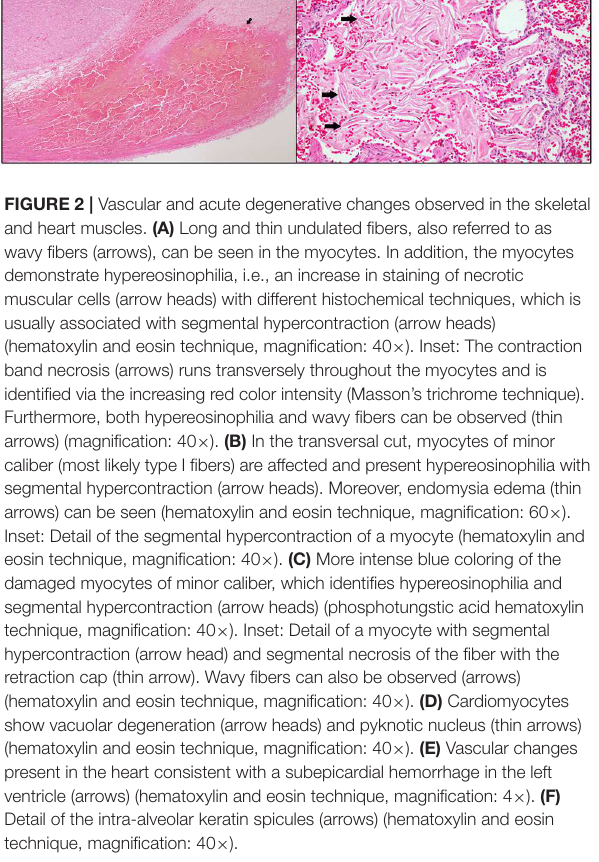
Immunohistochemically, the degenerated/necrotic muscular and heart cells showed homogenous, intrafibrillar depletion of cardiac troponin I, cardiac troponin C ( Figure 3A ), and myoglobin. Damaged cells from the skeletal and cardiac muscles were found to exhibit several concentrations of immunolabeling for fibrinogen ( Figure 3B ). The kidneys did not exhibit any accumulation of